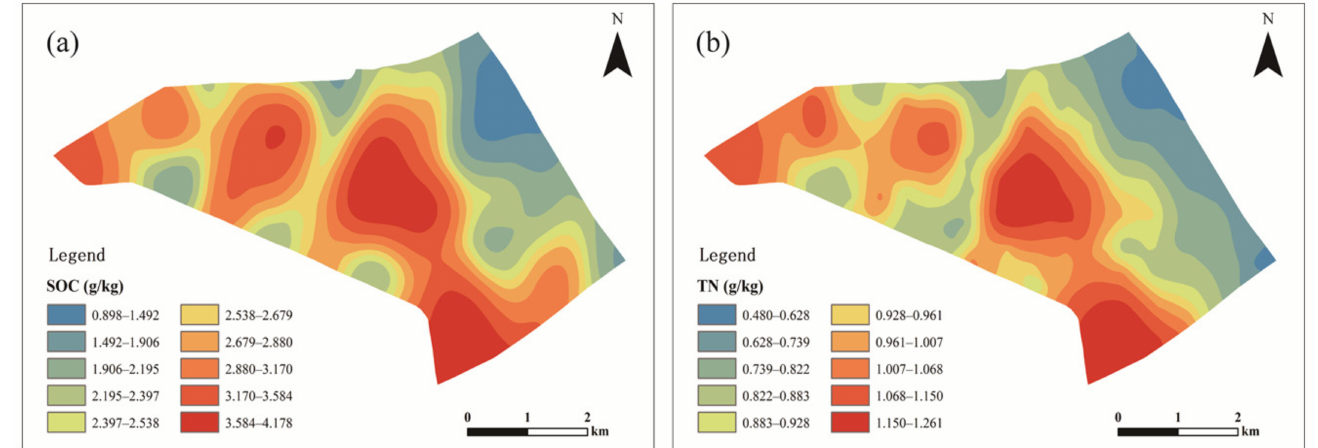
Figure 2. ( a ) Spatial distribution of soil organic carbon (SOC). ( b ) Spatial distribution of total nitrogen (TN).